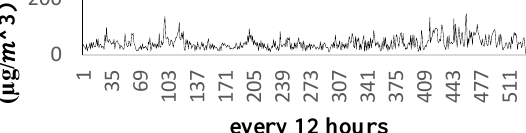
Figure 17. T he MLP network structure